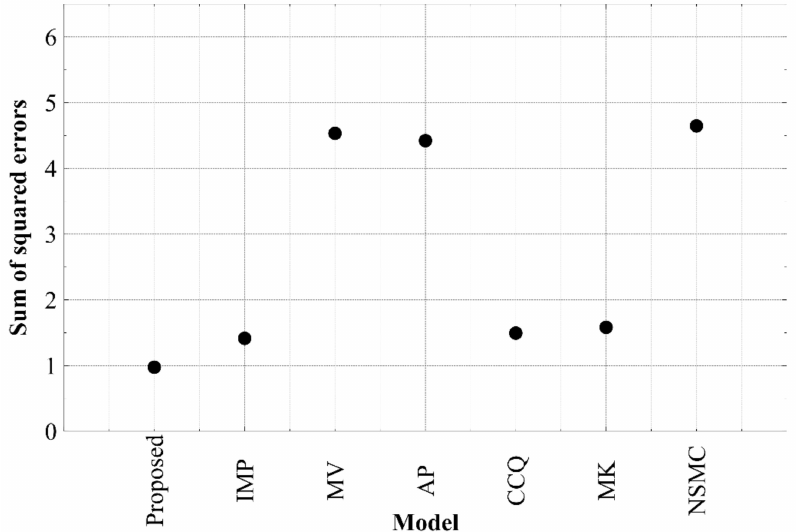
Figure 16. Sum of the squared errors, for each model, from the prediction of volumetric water content for each material in Figures